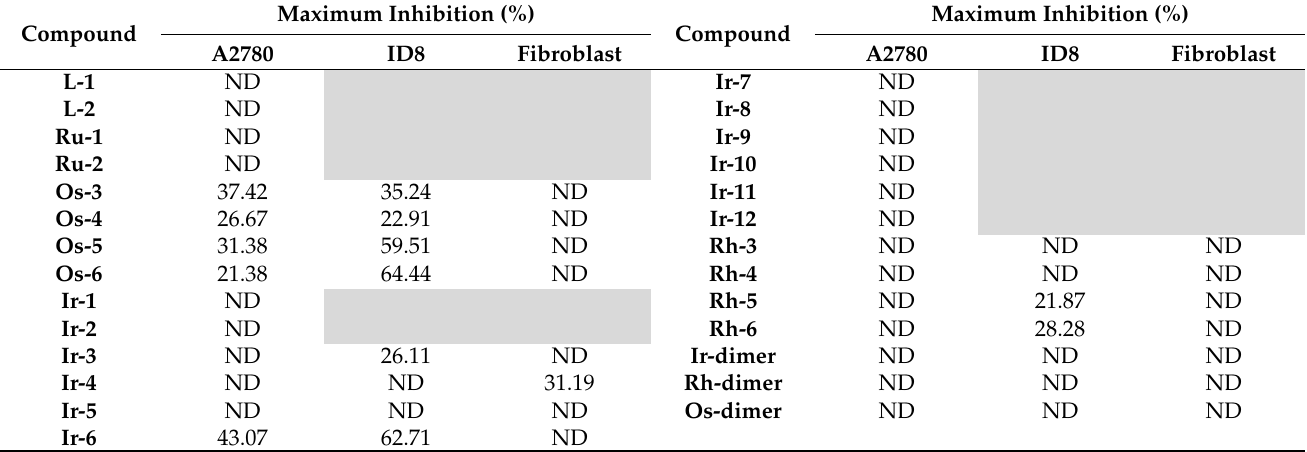
Table 4. Maximum inhibition in MTT